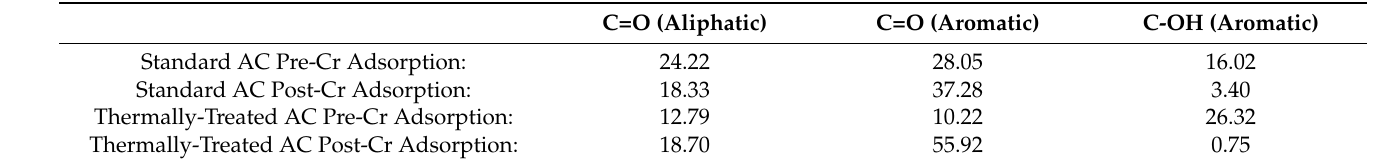
Table 6. Oxygen atom percent speciation from deconvolution of the XPS O1s peak pre- and